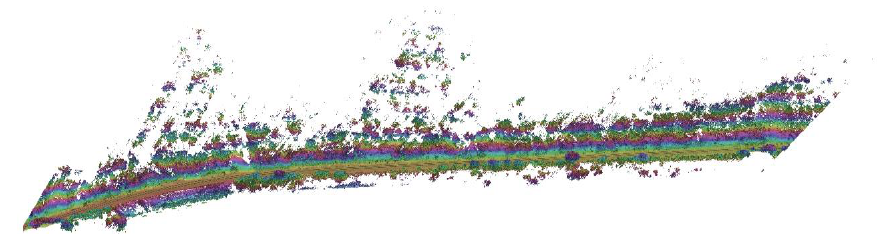
Figure 13. Elevation coloured point cloud obtained after data processing.